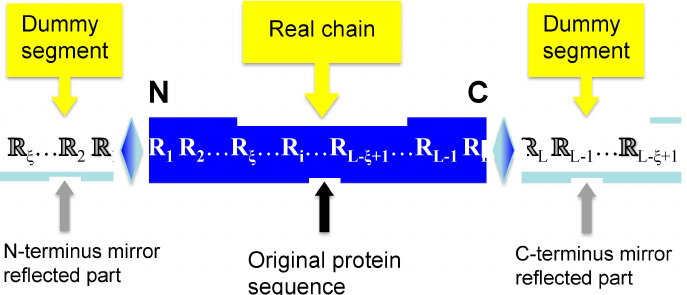
Figure 1. A schematic drawing to show how to use the extended chain of Equation (7) to define the working segments of Equation (6) for those sites when their sequence positions in the protein are less than ξ or greater L ´ ξ , where the left dummy segment stands for the mirror image of R 1 R 2 ¨¨¨ R ξ at N-terminus and the right dummy segment for that of R L ´ ξ ` 1 ¨¨¨ R L ´ 1 R L at the